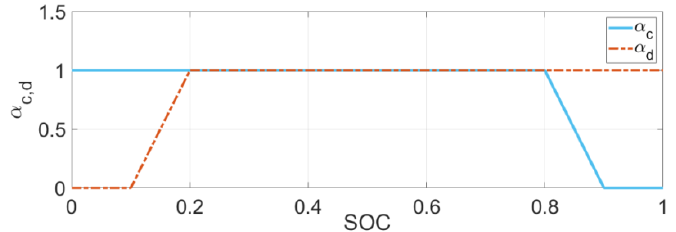
Figure 15. Battery power limiting coefficients for charging and discharging.